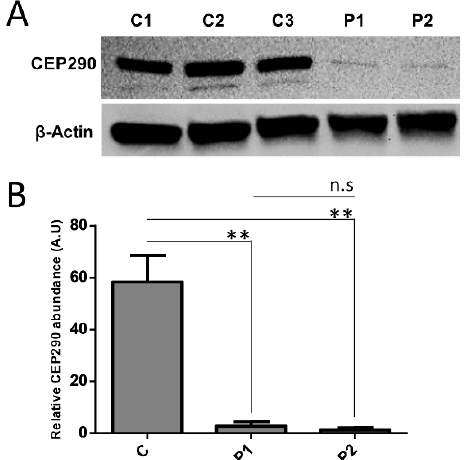
Figure 2. Effect of the natural exclusion of PTC-encoding exon 36 on CEP290 protein production. ( A ) Immune detection of the CEP290 and β -Actin in control cell lines (C1–C3) and mutant fibroblasts (P1 and P2). ( B ) Quantification of CEP290 abundance relative to β -Actin in control (C represents the pooled values of C1–C3) and patient fibroblasts. Bars correspond to the mean value ± SEM from four independent experiments. ** p ≤ 0.01, n.s = not significant.